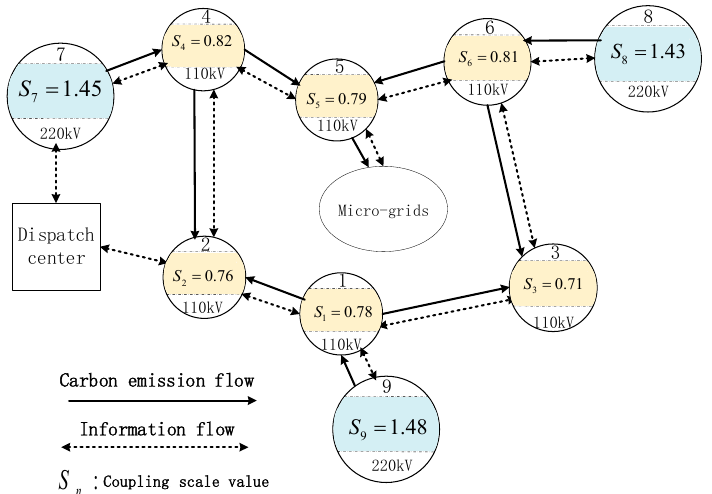
Figure 2. A dual-network coupling system based on carbon emission flow Figure 2. A dual ‐ network coupling system based on carbon emission flow network.